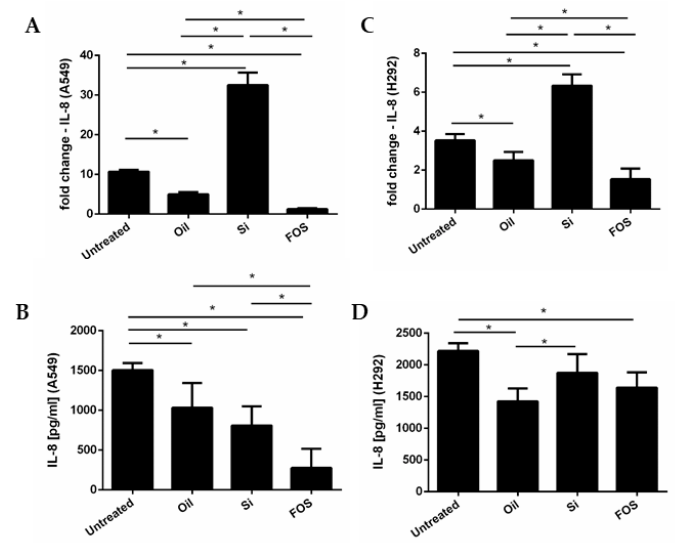
Figure 2. Effects of FOS on the expression of IL-8 mRNA and protein release. A549 and NCI-H292 were cultured with fish oil, silica, and FOS (10 µ g/mL) for 24 h; total RNA was extracted; and supernatants were collected to assess IL-8 gene expression by real-time PCR and IL-8 protein release using ELISA, respectively. ( A , B ) report data on IL-8 gene expression and IL-8 protein release in A549 cells, respectively. ( C , D ) report data on IL-8 gene expression and IL-8 protein release in NCI- H292, respectively. Results are expressed as mean ± SD (n = 3). A comparison between different experimental conditions was evaluated by ANOVA corrected with Fisher’s test. * p < 0.05 was accepted as statistically